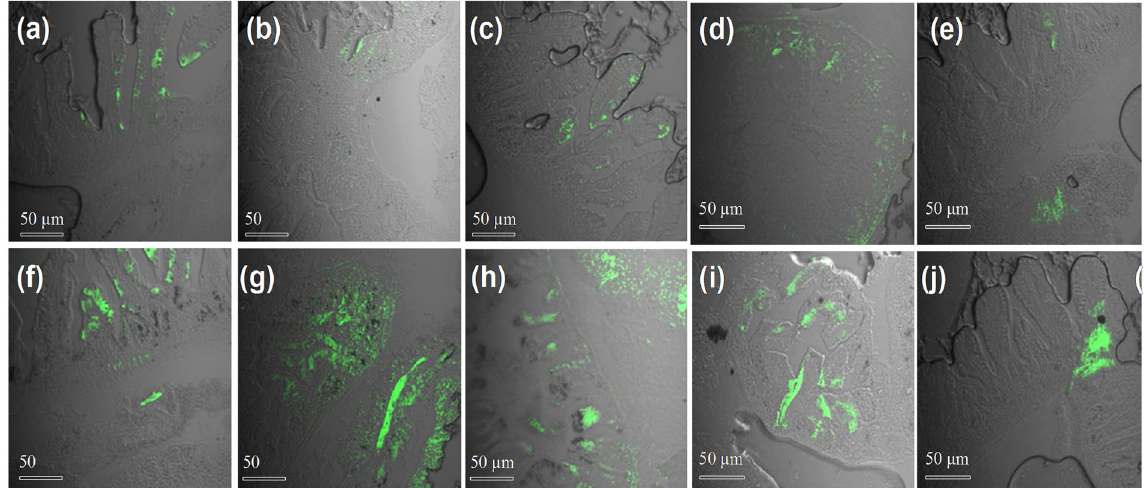
Figure 4. Confocal images of zebrafish digestive system injected with Fluorescein conjugated G-AuNPs after 4 h: ( a ) S-1, 4 h; ( b ) R-1, 4 h; ( c ) St-1, 4 h; ( d ) R-2, 24 h; ( e ) R-2, 48 h; ( f ) S-2, 4 h; ( g ) R-2, 4 h; ( h ) St-2, 4 h; ( i ) St-2, 24 h; ( j ) St-2, 48